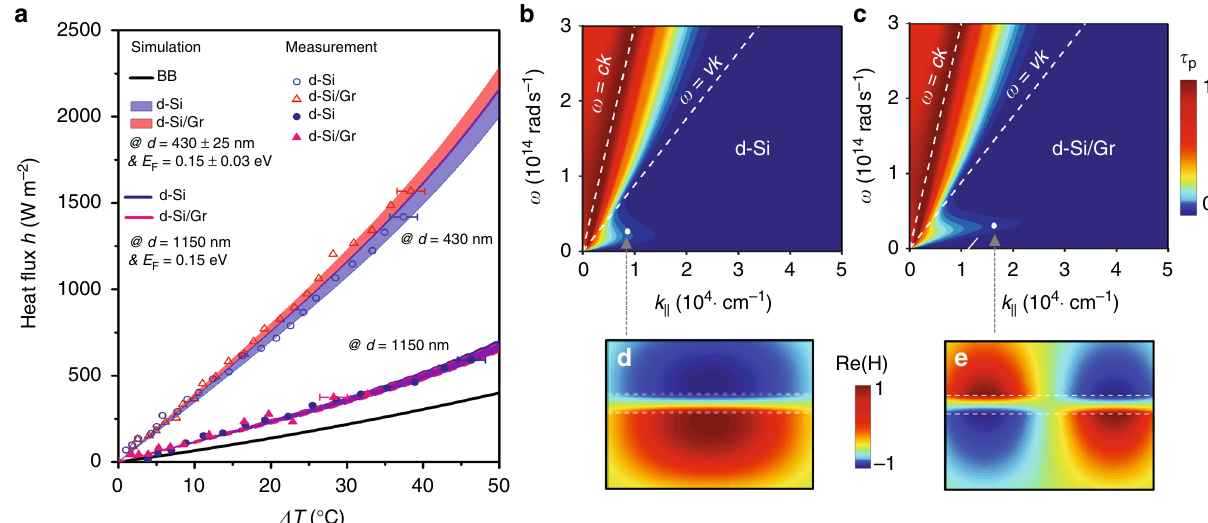
Fig. 5 Heat fl ux density and transmission possibility between d-Si/Gr pair. a The measured heat fl ux density (symbols) compared with the analytical predictions (shaded regions) at different temperature difference ( T r is fi xed at 30 °C). The solid circles and triangles represent the measured heat fl ux density between a pair of bare d-Si and d-Si/Gr, respectively, at the gap d = 1150 nm. These results can be well reproduced by the theory (solid royal and pink lines) using the measured material parameters. The empty circles and triangles represent the heat fl ux density measured at the gap of d = 430 nm for bare d-Si and d-Si/Gr pairs, respectively. The corresponding blue/red shaded region pro fi les the theoretical fl ux density distribution when considering the parametric fl uctuations: E F = 0.15 ± 0.03 eV and d = 430 ± 25 nm. The black line denotes the fl ux density of Blackbody radiation. The temperature error bar is 2 °C derived from the fi ve times repeating measurement. b , c p -polarization transmission possibility τ p ( ω , k || ) between bare d-Si pair and d-Si/Gr pair, respectively. d , e The inter-layer mode patterns using magnetic component between bare d-Si pair and d-Si/Gr pair at (1.23 × 10 4 rad cm − 1 , 3.02 × 10 13 rad s − 1 ) and (1.94 × 10 4 rad cm − 1 , 3.02 × 10 13 rad s − 1 ), respectively. Figure 5 by Yang J et